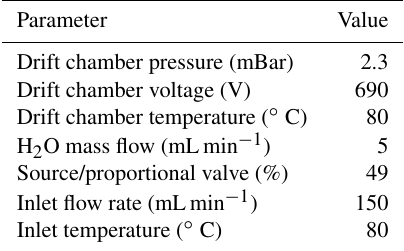
Table A1. PTR–MS method used for measurements.